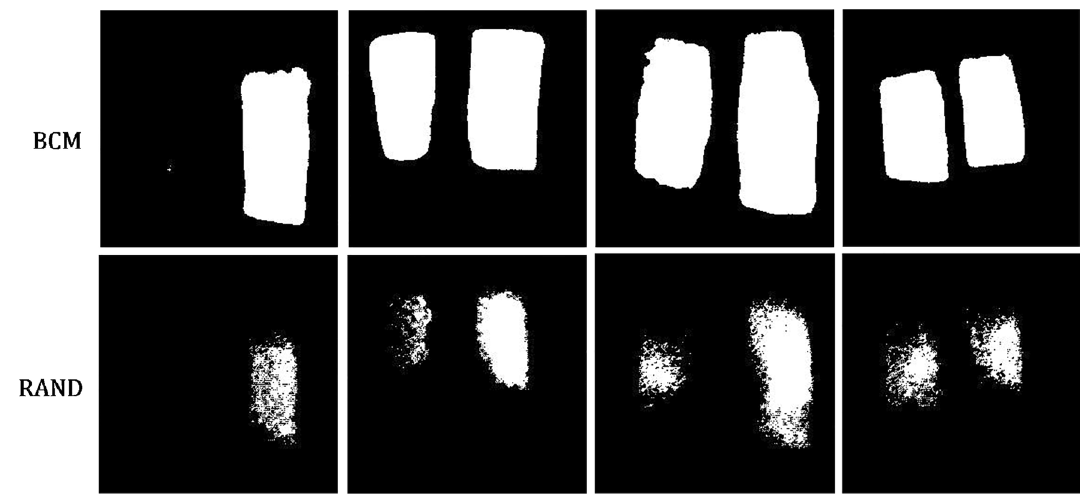
Figure 5. Example masks generated using the batch control method and random (RAND) models. The selected examples demonstrate the scattered pixels observable in some results generated from the RAND model.